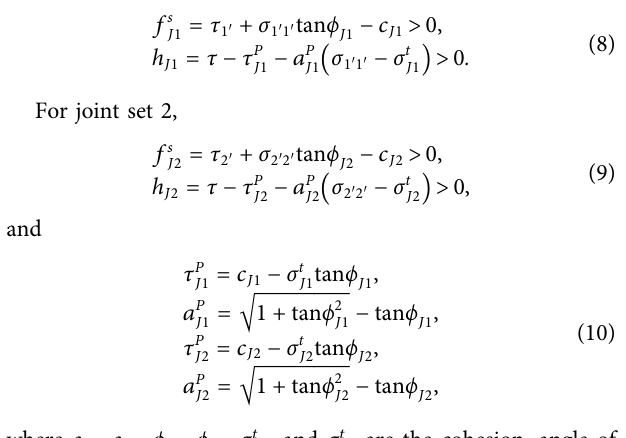
Frontiers in Earth Science |